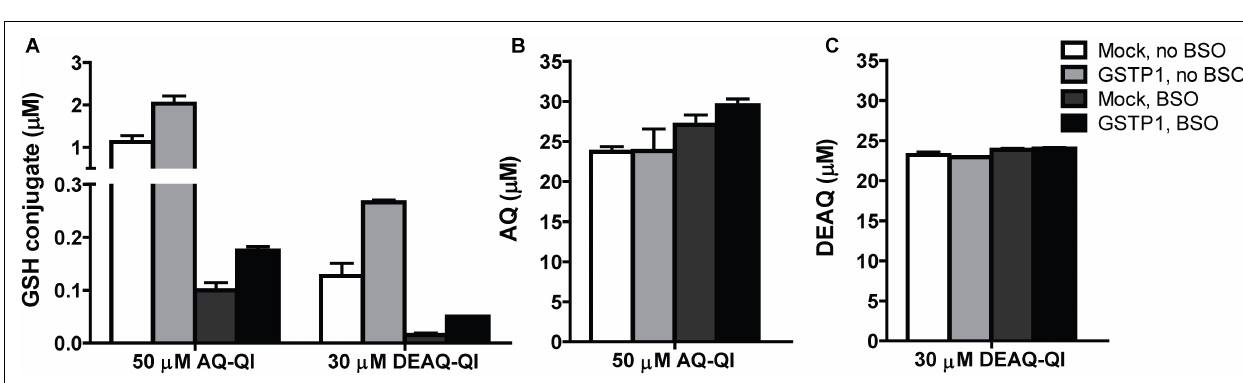
FIGURE 5 | Concentrations of GSH-conjugates of AQ-QI (AQ-SG) and DEAQ-QI (DEAQ-SG) (A) , AQ (B) , and DEAQ (C) in total lysates of mock- and GSTP1-transfected HepG2 cells. When applicable, pre-exposure of 500 µ M BSO was performed 24 h before treatment. Cells were treated with 50 µ M AQ-QI or 30 µ M DEAQ-QI for 2.5 h, after which GSH conjugates and reduces QIs were analyzed using HPLC. Results are presented as mean ± SD from four independent